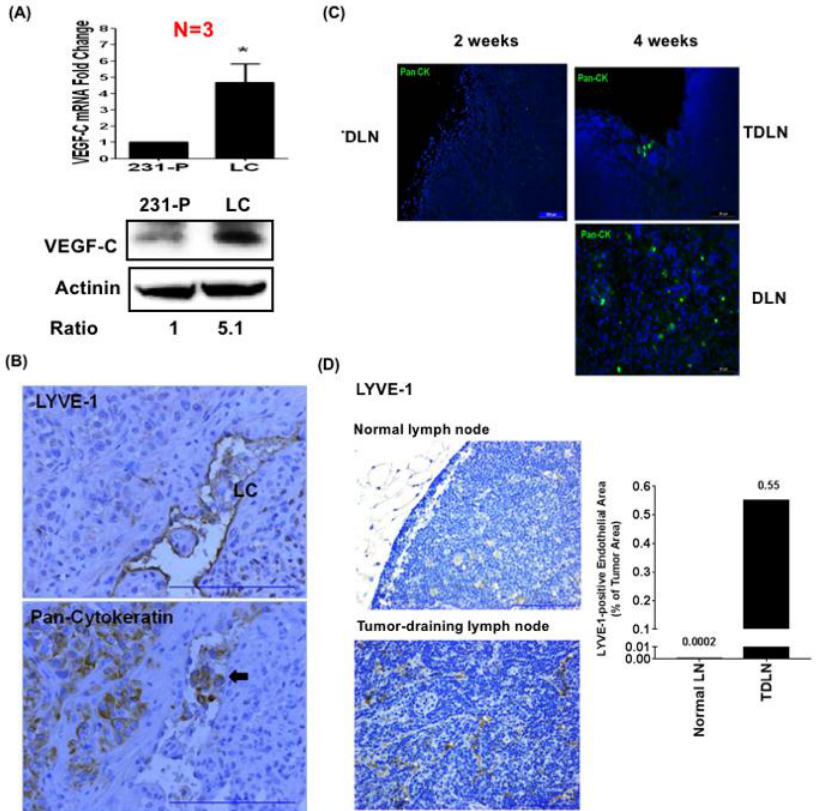
Figure 1. High lymphatic-tropic metastasis LC cells derived from MDA-MB-231 cells via in vivo selection express high levels of VEGF-C and show strong lymphatic invasion ability. ( A ) Quantitative RT-PCR assay demonstrated a 4.7-fold increase of VEGF-C expression in LC cells when compared with parental MDA-MB-231 cells (231-P). VEGF-C protein levels were also increased in LC cells. * p < 0.05. ( B ) The tumors generated from LC cells showed intensive lymphanagiogenesis (upper panel) as evidenced by LYVE-1-positive lymphatic endothelial vessels. The invasion of LC cancer cells was also shown by the pan-cytokeratin-positive cells in the lumens of lymphatic vessels. ( C ) Immunofluorescent staining demonstrated the appearance of LC cancer cells in tumor-draining lymph nodes (TDLN) and distant lymph nodes (DLN). Scale bar: 50 µ m. ( D ) The TDLN of LC tumors isolated at week four after cancer cell inoculation showed extensive lymphangiogenesis, while very little lymphangiogenesis was found in the lymph nodes of normal mice. Scale bar: 50 µ